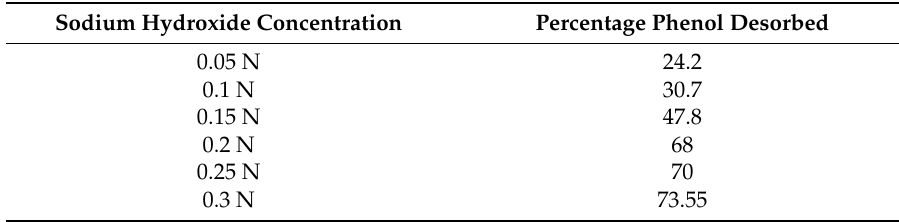
Table 4. Fraction of desorbed phenol from magnetic ZnO nanotubes using NaOH solution after